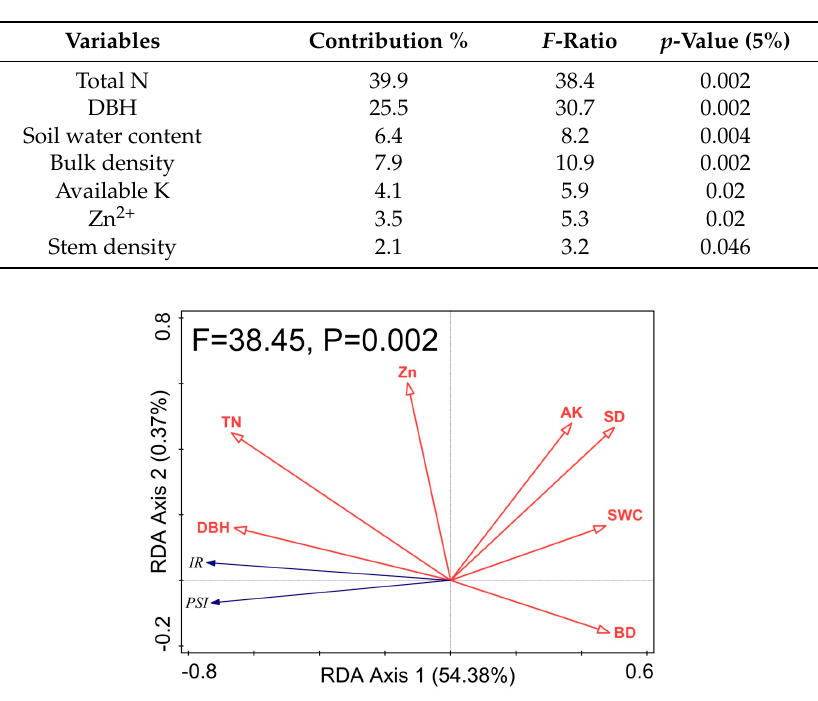
Table 6. Forward selection of seven significant environmental variables by Monte Carlo permutation test in RDA.